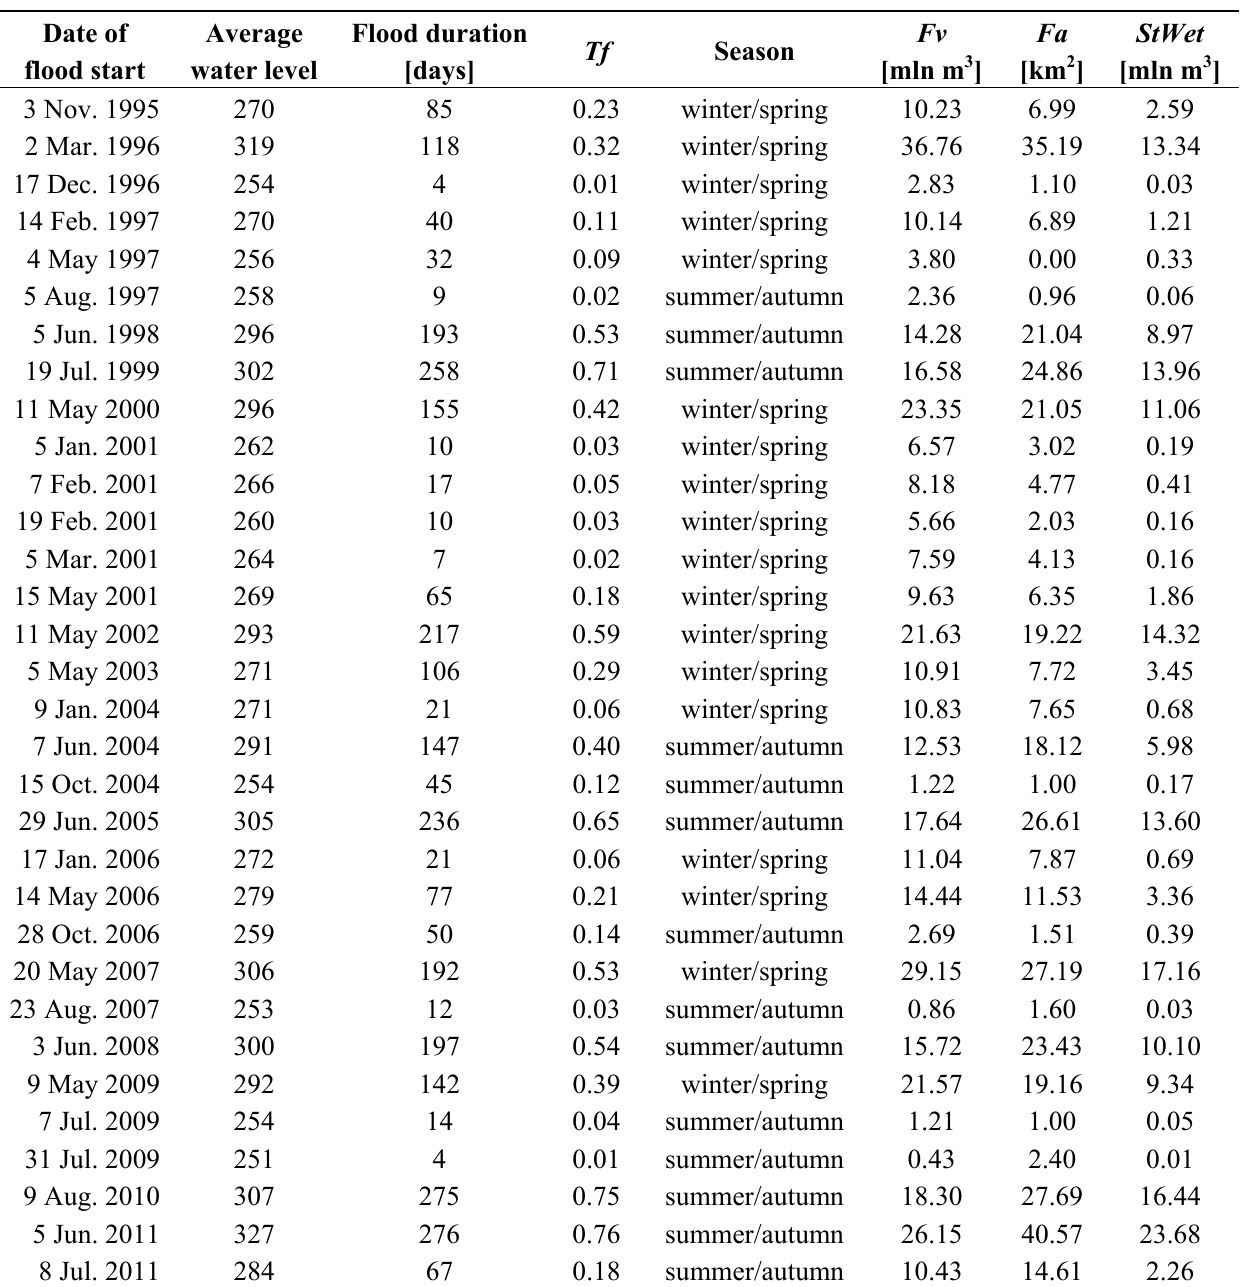
Table 2. Calculations of the total active water storage volume in the floodplain of the Lower Biebrza Basin. Hydrological data obtained from the Institute of Meteorology and Water Management